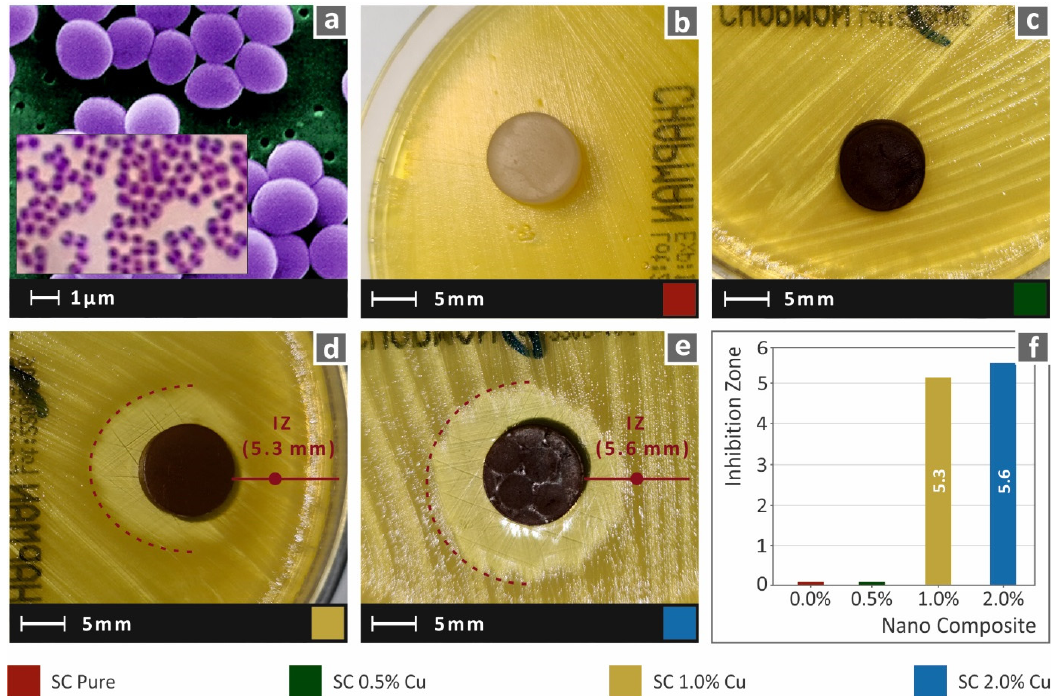
Figure 13. ( a ) typical S. Aureus morphology, ( b – e ) Vertical captures after 24 h cultivation of tested specimen in Petri dish for each corresponding tested material, ( f ) Comparative graph of the measured inhibition zones to filler loading (wt.%).